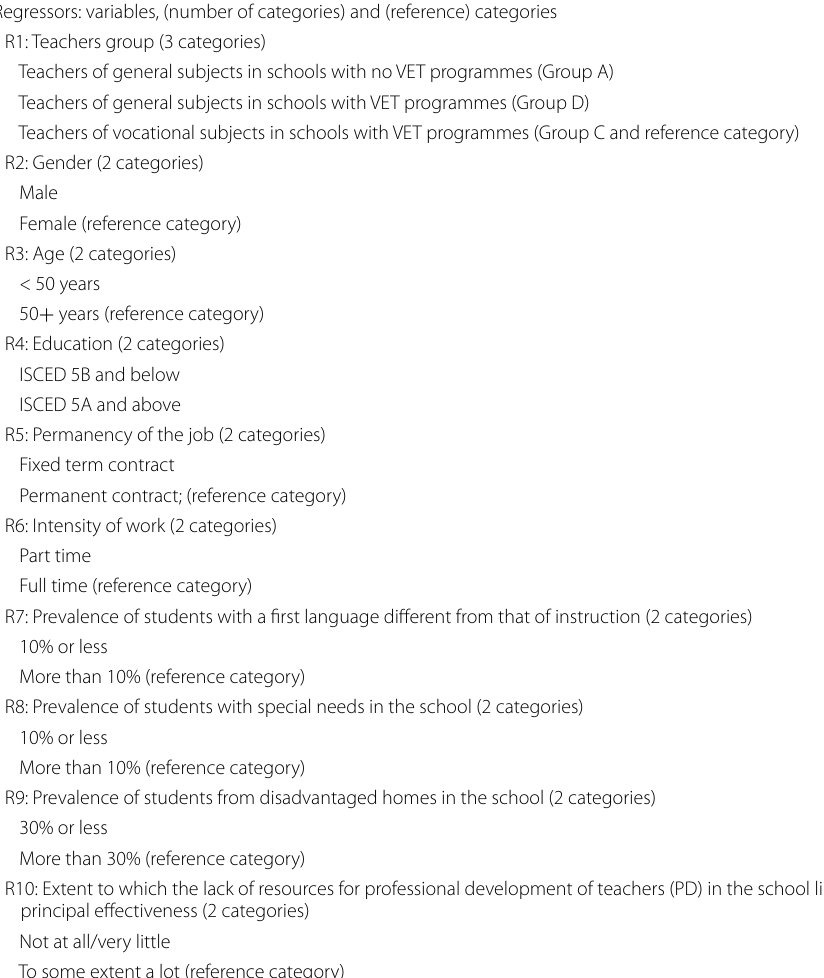
Table 12 Background variables (regressors) used in logistic regression models (Source: Author’s recoding based on OECD, TALIS